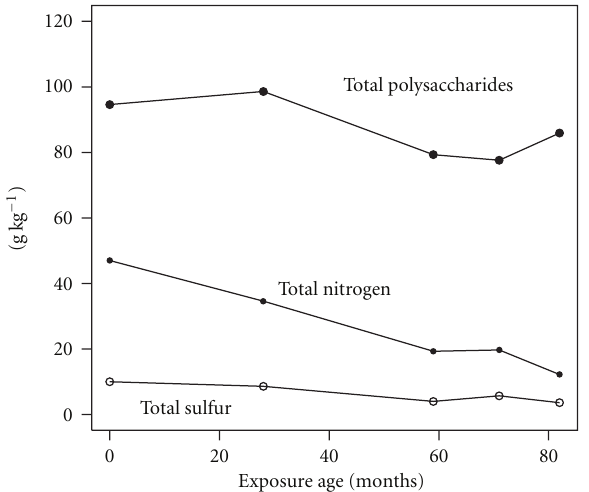
Figure 17: Total sulfur, nitrogen, and polysaccharide content in biosolids as a ff ected by age of exposure on the soil surface (redrawn from